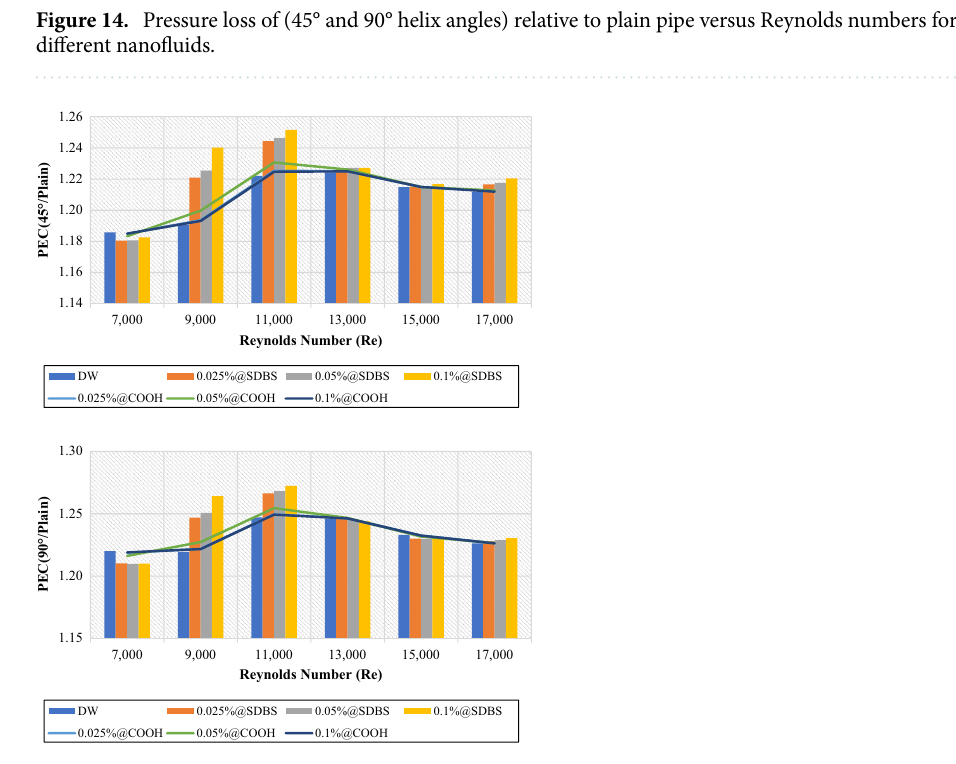
Figure 15. Performance evaluation criterion of (45° and 90° helix angles) relative to plain pipe versus Reynolds numbers for different